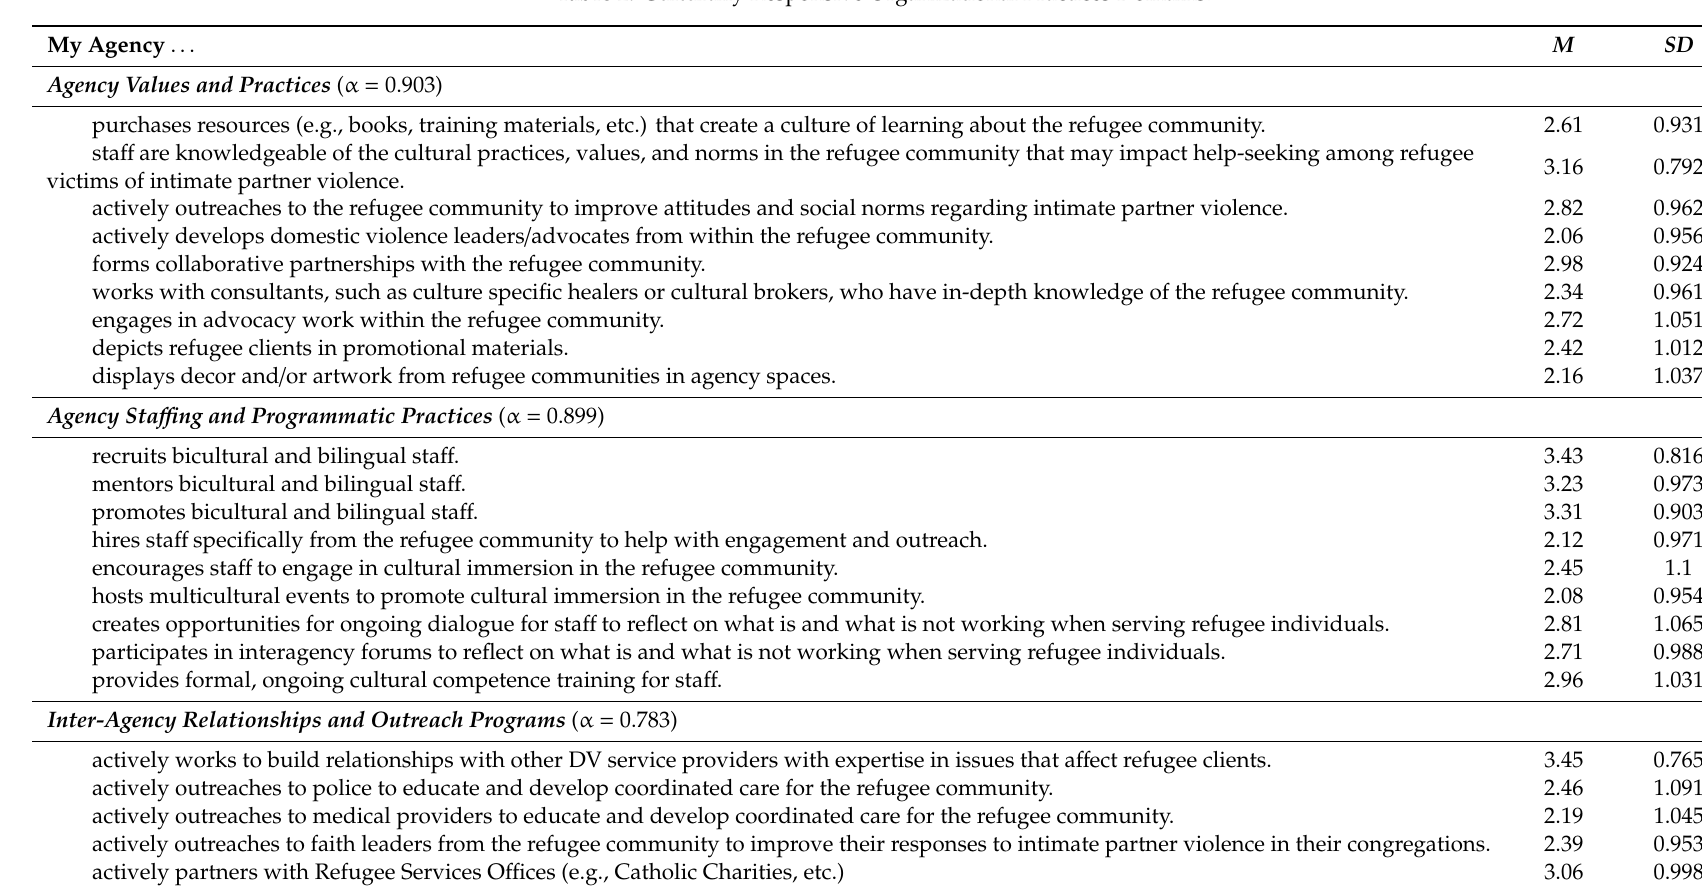
Table 2. Culturally Responsive Organizational Practices